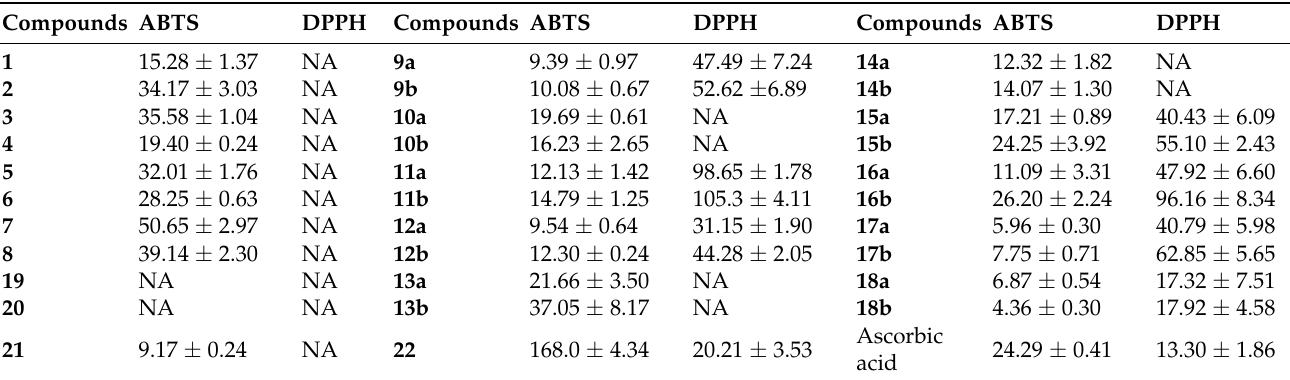
Table 1. The free radical scavenging activity of the constituents from V. bracteatum a .